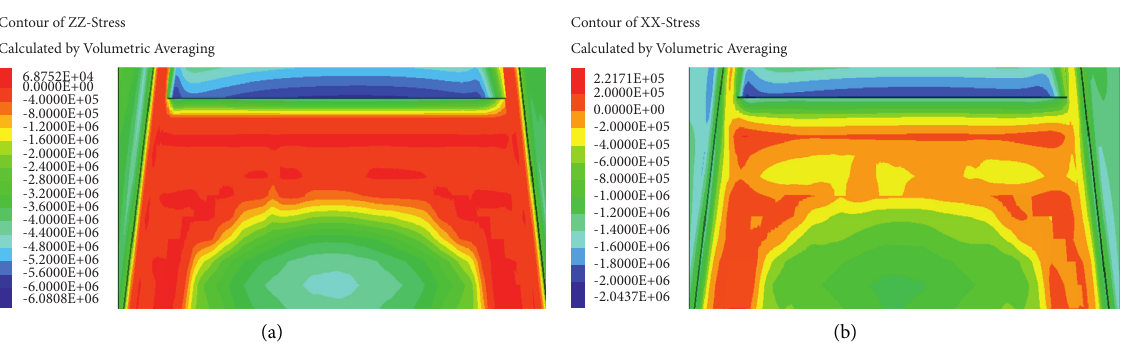
Figure 16: Stress distribution while excavating a face for 60m. (a) Vertical stress. (b) Horizontal stress.